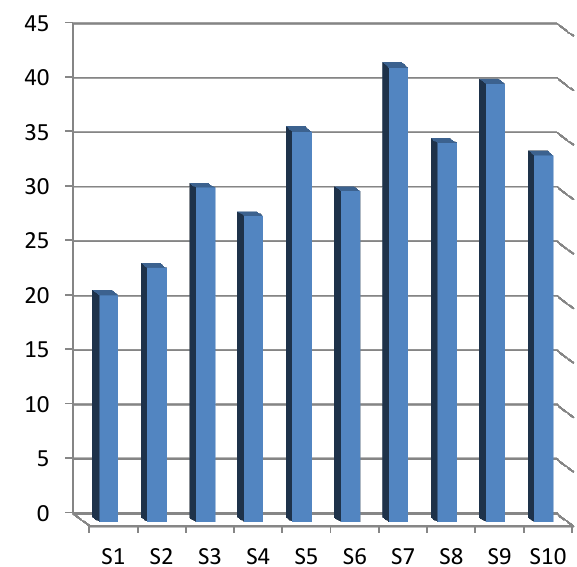
Fig. 5: The effective doses rate D(nGy/h) at soil